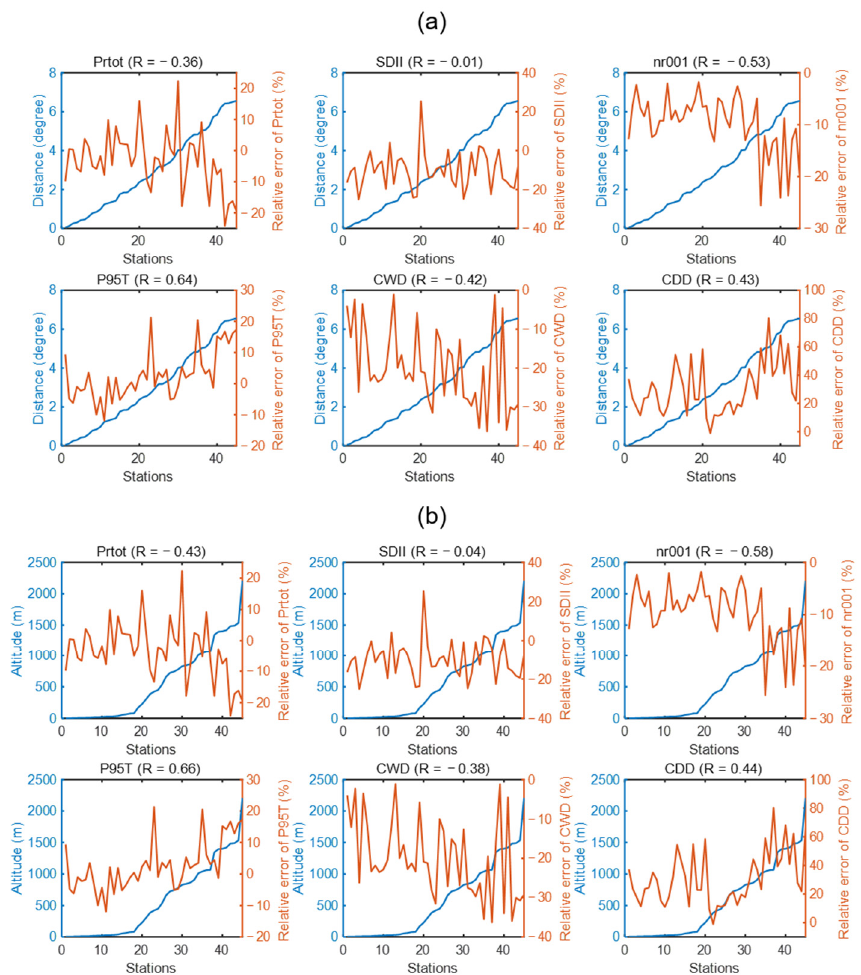
Figure 15. Contrast of simulation accuracy between ( a ) inland and coastal stations (sorted by the shortest distance from the coastline); ( b ) different altitude stations (sorted by altitude). Altitude was positively correlated with P95T (0.66) and CDD (0.44), negatively cor- related with Prtot ( − 0.43), nr001 ( − 0.58), and CWD ( − 0.38), and weakly correlated with SDII ( − 0.04) (Figure 15b). This result implies an overestimation of precipitation simula- tions for stations at lower altitudes and an underestimation of precipitation simulations for stations at higher altitudes. In this paper, the results imply that the different modes obtained using SOM can reflect different characteristics of precipitation distribution. The relationship between weather patterns and precipitation is reasonable. On this basis, the relationship between the main weather modes and the probability distribution of precipitation conditions at each station can be easily established, thus realizing the SOM-SD model. The simulated precipitation has a more consistent daily precipitation probability distribution with the observed precipitation. Moreover, it has some simulation capability for extreme precipi- tation. The precipitation downscaling method established in this study has good adapta- bility to North China and can be used for downscaling of current precipitation and sce- nario prediction of future precipitation in North China. Therefore, this method can signif- icantly improve the downscaling seasonal climate prediction capability of the global cli- mate model for regional precipitation, and can provide an effective means for regional refined seasonal climate prediction.